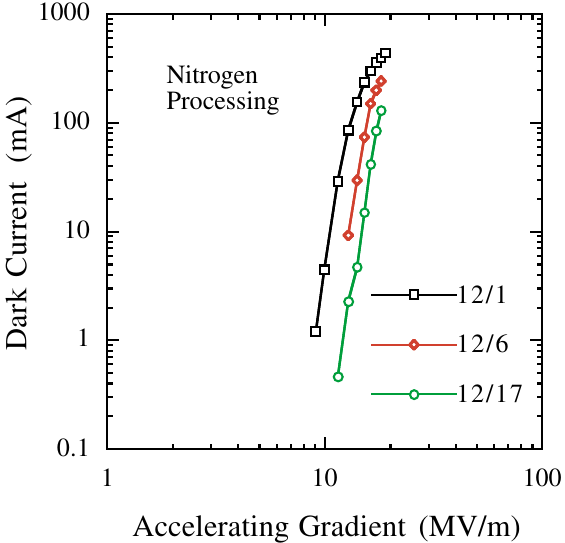
FIG. 14. (Color) Dark current measurements during nitrogen conditioning.